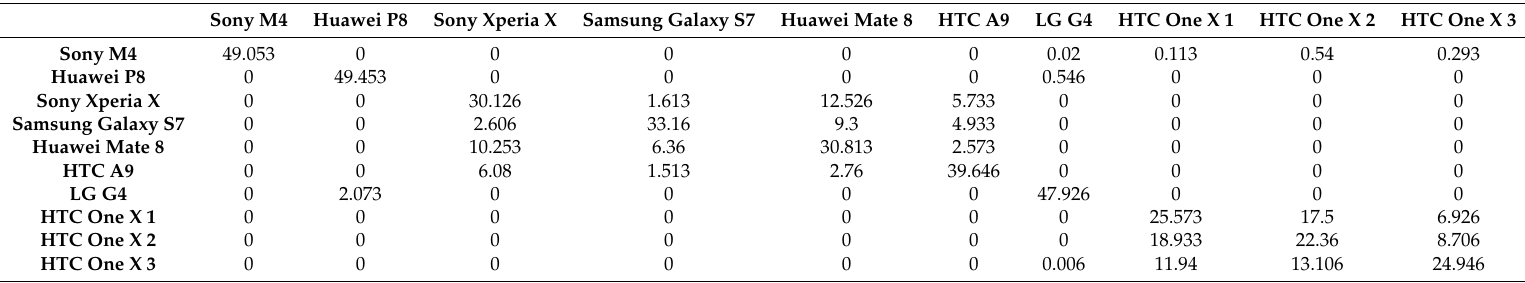
Table 3. Confusion matrix based on SVM and optimal values for the digital output generated by the magnetometer on the X axis. Values have been averaged over the 50 repetitions.